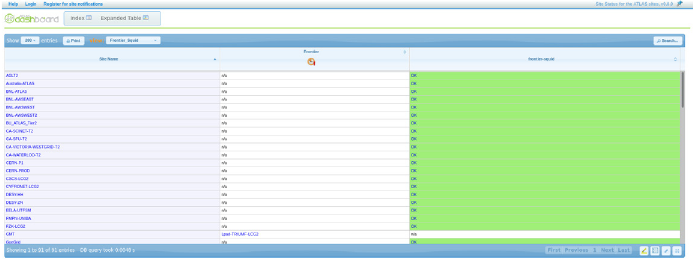
Figure 6. Kibana monitoring page of Frontier